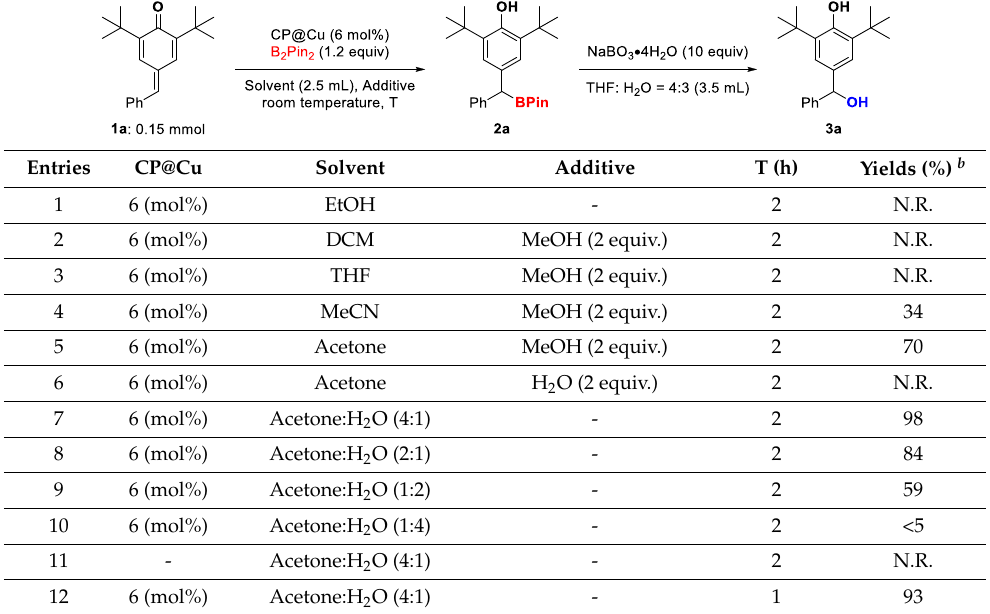
Table 1. Reaction condition optimizations a .